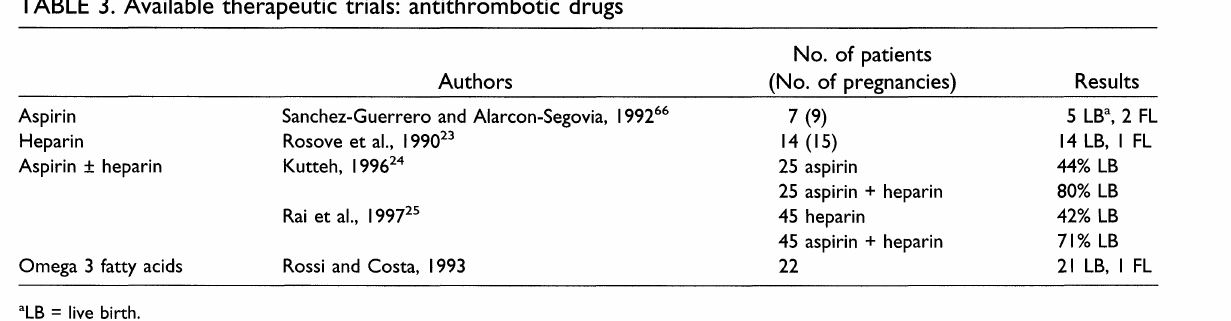
TABLE 3. Available therapeutic trials: antithrombotic drugs